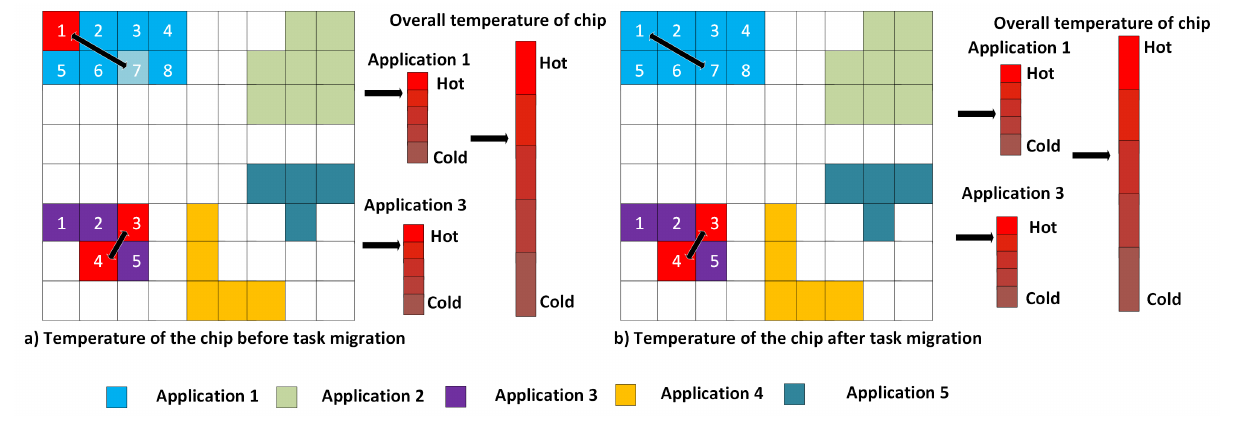
Figure 3. An Example of Task